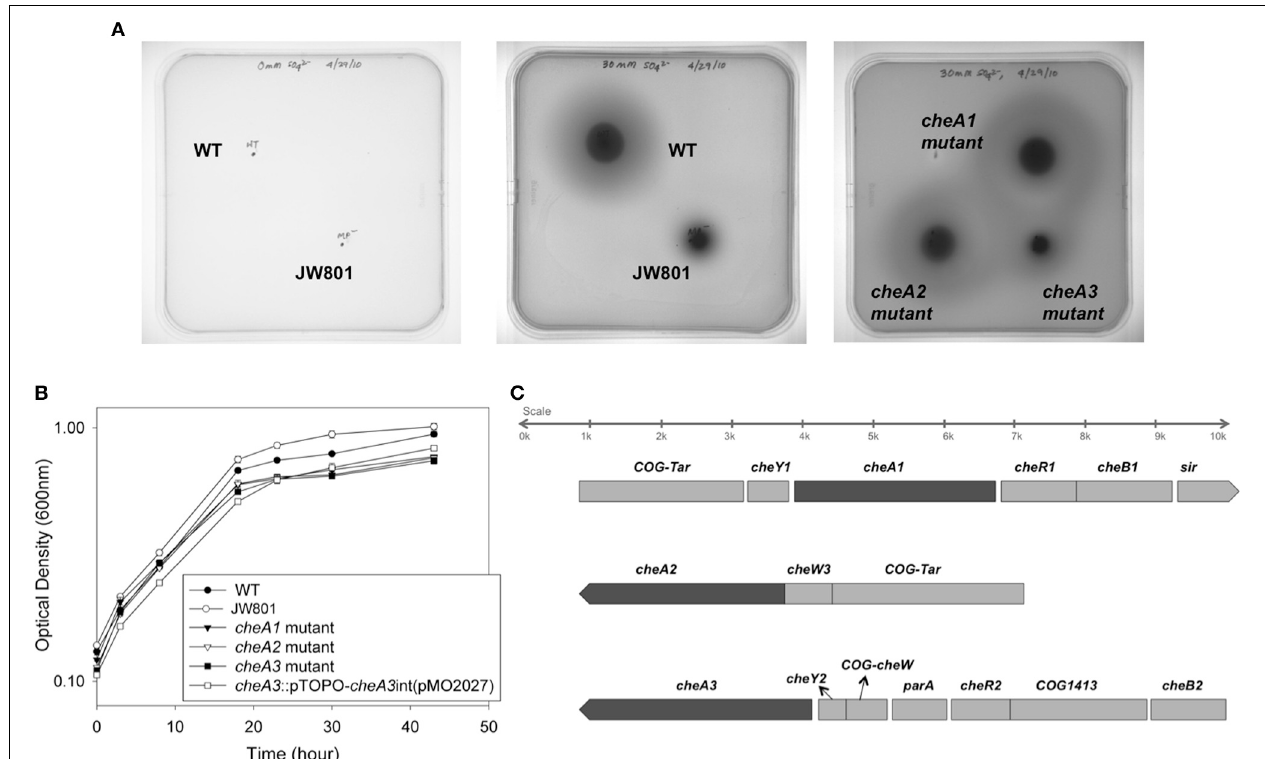
FIGURE 1 | (A) Soft agar plate assays for D. vulgaris wild type, JW801, CA023 ( cheA1 mutant), CA007 ( cheA2 mutant), and CA022 ( cheA3 mutant) strains in modified LS4D medium as described in methods with 0.4% (wt/vol) agar. Motility halos were imaged after 4 days of incubation in an anaerobic chamber at 30 ◦ C. No growth was observed for either the wild type or JW801 strain in the control plate that contains no sulfate (left panel). In LS4D plates, the wild type forms a motility halo, whereas, JW801 was impaired in forming a halo (center panel); the cheA3 mutant shows a defect in motility (right panel) relative to the cheA1 and cheA2 mutants and the wild type. (B)